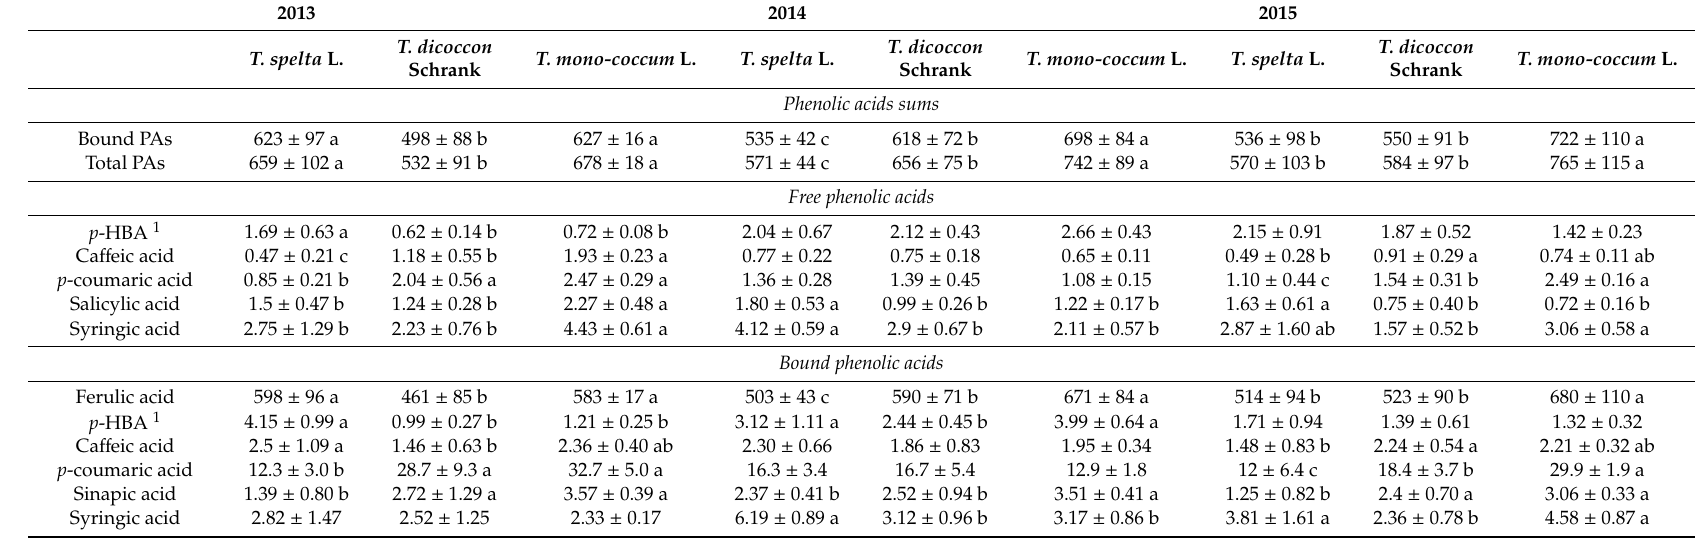
Table 4. Interactions between wheat species and cultivation year for free and bound phenolic acids (PAs) concentration ( µ g / g dry mass) in whole grain flour. All values are means ± standard deviations for four experimental replicates. Values in columns for wheat species within each cultivation year followed by the same letter are not significantly di ff erent at p <